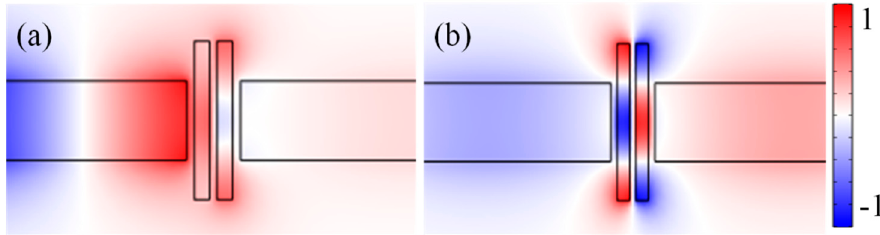
Figure 3. Steady state magnetic field H z distributions for the ( a ) transmission dip (580 nm); and ( b ) transmission peak (620 nm) of the MIM waveguide-coupled double rectangular cavities.